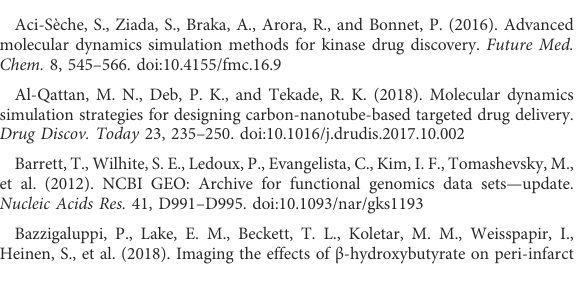
SUPPLEMENTARY FIGURE S7 MDS secondary structure and binding free energy analysis. (A) Plots of individual secondary structures of proteins in the MDS system with time. (B) Binding free energy between GSSG-ECSH1 complexes. (C) Relationship between each contact residue and binding in the GSSG- ECSH1 complex. (D) Plot showing each secondary structure of the GSSG- GSTT1 complex with time in the MDS system. (E) Binding free energy between GSSG-GSTT1 complexes. (F) Relationship between each contact residue and binding in the GSSG-GSTT1 complex. (G) Plot showing the individual secondary structures of the GSSG-HSD17B10 complex in the MDS system with time. (H) The binding free energy between GSSG- HSD17B10 complexes. (I) The relationship between each contact residue and binding in the GSSG-HSD17B10 complex. Notes: Negative energy indicates strong binding ability. ‘ Total ’ indicates the system ’ s total energy, which represents the ability of the protein and small molecule to interact with each other. VDWAALS- van der Waals energy; EEl- Electrostatic energy; EGB- Polar solvation energy; ESURF- Non-polar solvation energy; GGAS- Total gas phase free energy; GSOLV- Total solvation free energy; TOTAL free energy- GSOLV + GGAS. SUPPLEMENTARY FIGURE S8 MDS secondary structure analysis and binding free energy analysis. (A) Plots of the individual secondary structures of the GSSG-LDHA complex proteins in the MDS system over time. (B) Binding free energy between GSSG-LDHA complexes. (C) Relationship between each contact residue and binding in the GSSG-LDHA complex. (D) Plot illustrating the change in each secondary structure between GSSG- LDHB complexes with time in the MDS system. (E) Binding free energy between GSSG-LDHB complexes. (F) Relationship between each contact residue and binding in the GSSG-LDHB complex. Notes: Negative energy indicates a strong binding ability. “ Total ” indicates the system ’ s total energy and represents the ability of the protein and small molecule to interact. VDWAALS- van der Waals energy; EEl- Electrostatic energy; EGB- Polar solvation energy; ESURF-